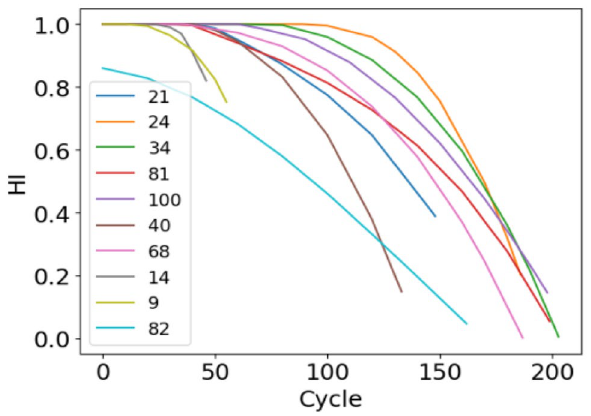
Figure 8. 10 HI curve of the test set.